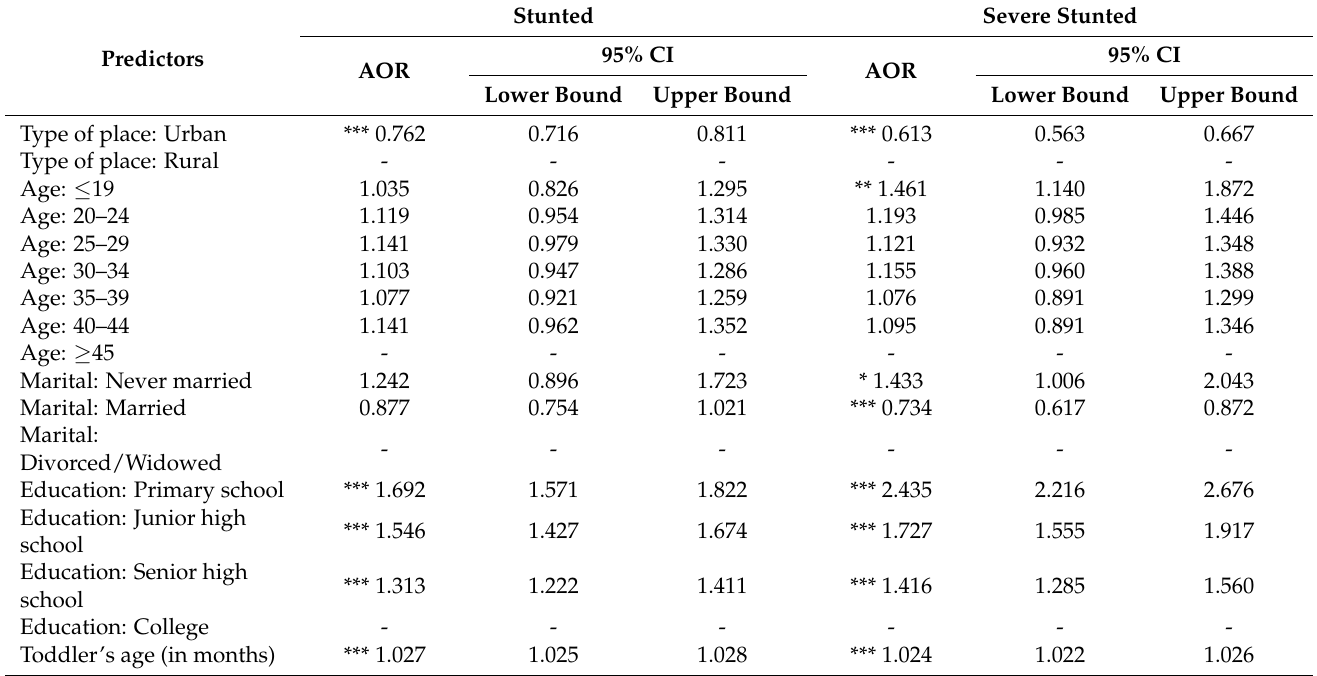
Table 2. The results of multinomial logistic regression analyses of stunted toddlers with working mothers in Indonesia in 2017 ( n =